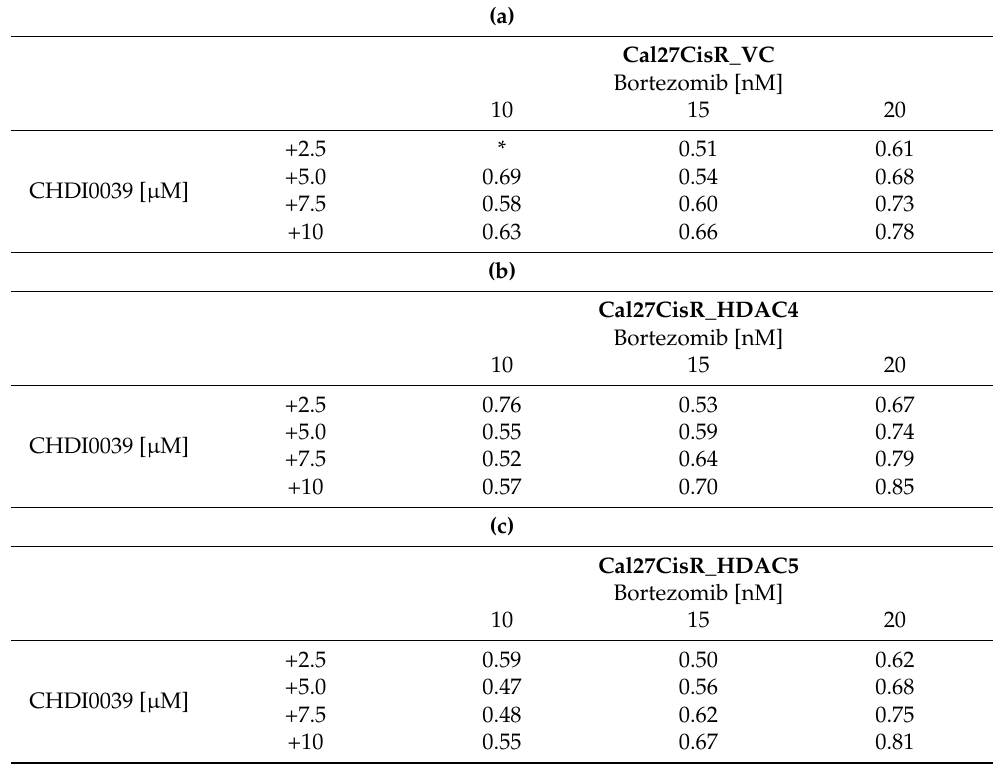
Table 6. CI values according to Chou–Talalay of the drug combination CHDI0039 and bortezomib in Cal27CisR_VC, Cal27CisR_HDAC4, and Cal27CisR_HDAC5. * = fraction affected less than 20%. Values represent means of at least three independent